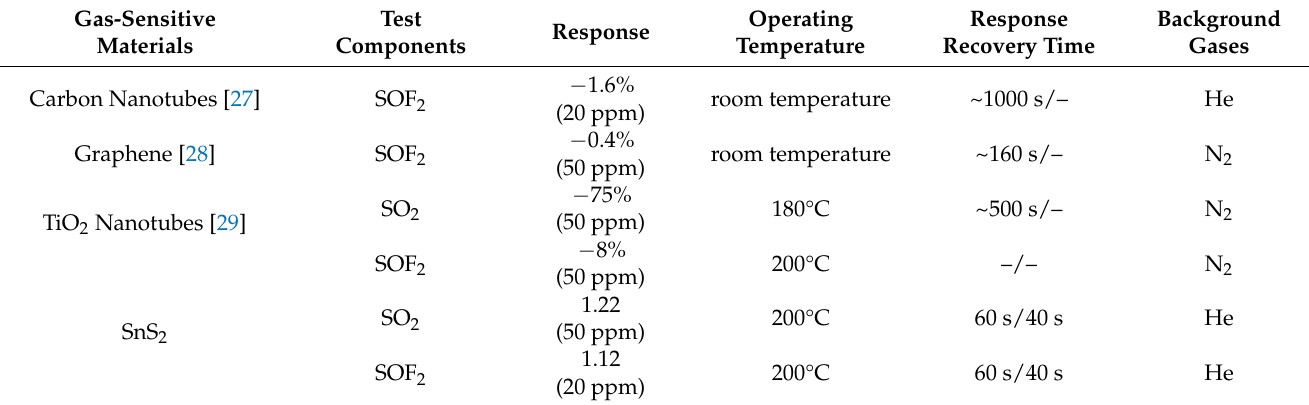
Table 1. Comparison of recent pristine sensing materials of detecting SF6